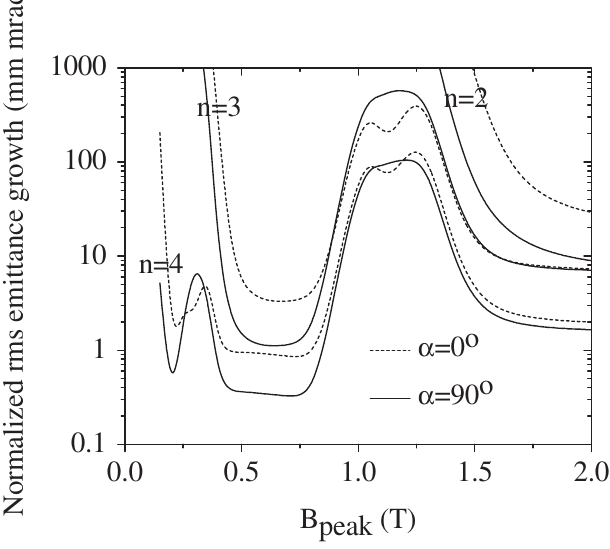
FIG. 2. Emittance growth as a function of peak magnetic field n ¼ 2 , 3, and 4 of a hydrogen B max for different excited states atom and different polarizations of the